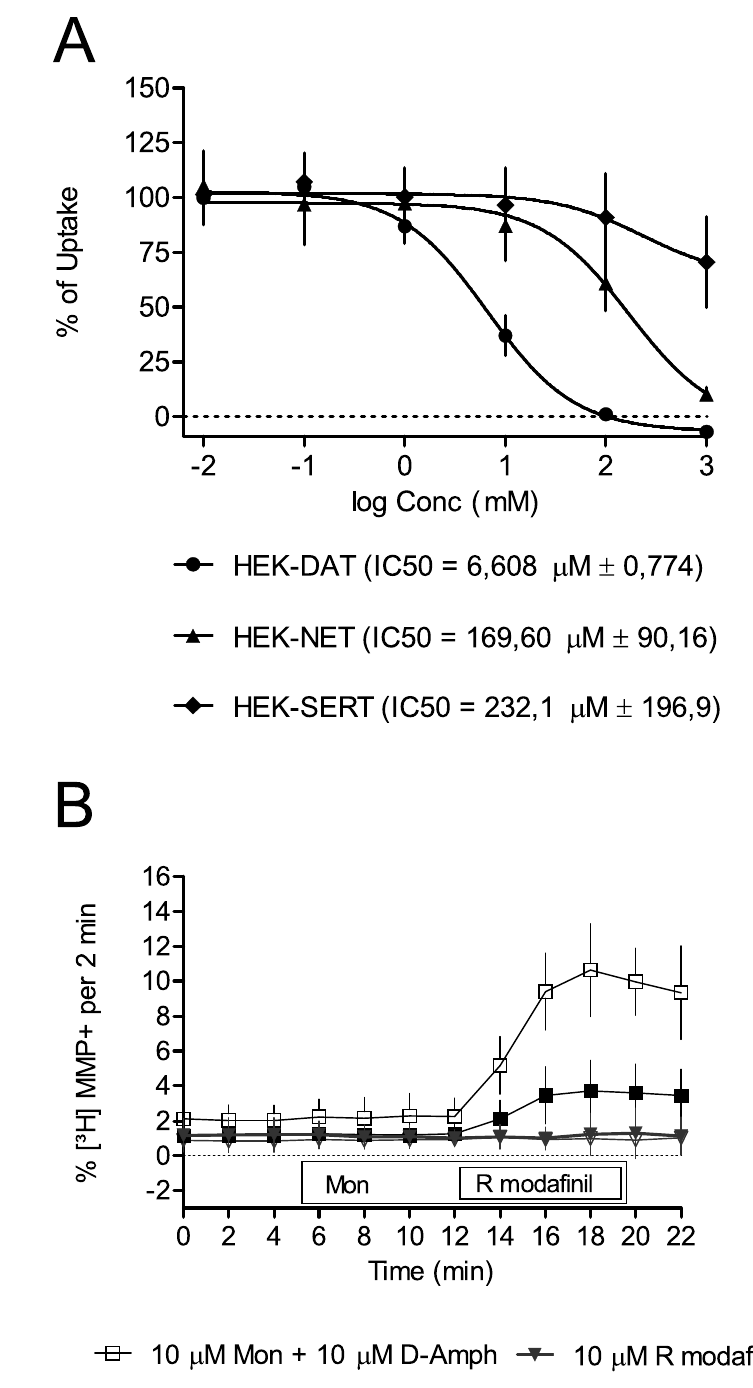
Fig 2. Monoamine neurotransmitter reuptake inhibition and releaseassay. (A) Inhibitionof [ 3 H]DA, [ 3 H] MPP + and [ 3 H]5-HT reuptake by increasing concentrations of R-modafinil in HEK293 cells stably expressing humanisoforms of DAT, NET and SERT. Experiments were performed as describedin the methods section. Unspecific uptake was determinedby using 10 μ M mazindolefor HEK-DAT and HEK- NET and 10 μ M paroxetine for HEK-SERT. The percentage of maximum uptake was determined by using 1% DMSO in KHB.